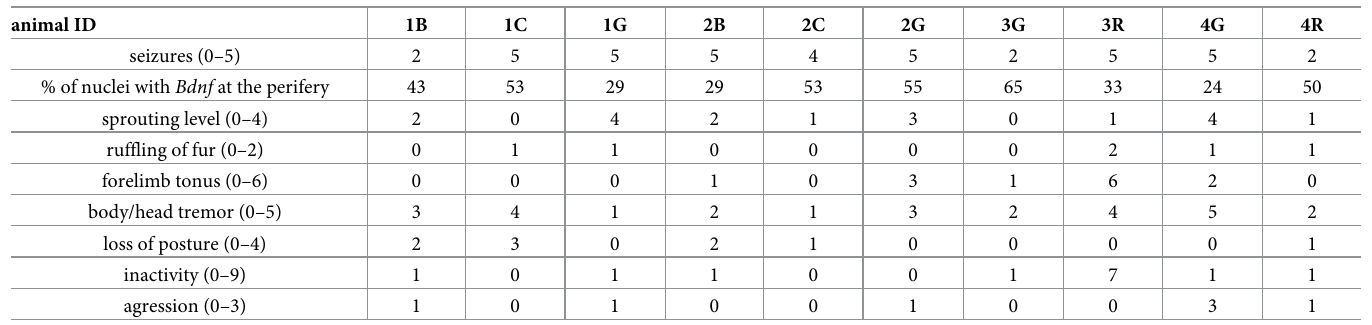
Table 1. Estimation of the clinical and morphological traits in the kainate model of TLE.